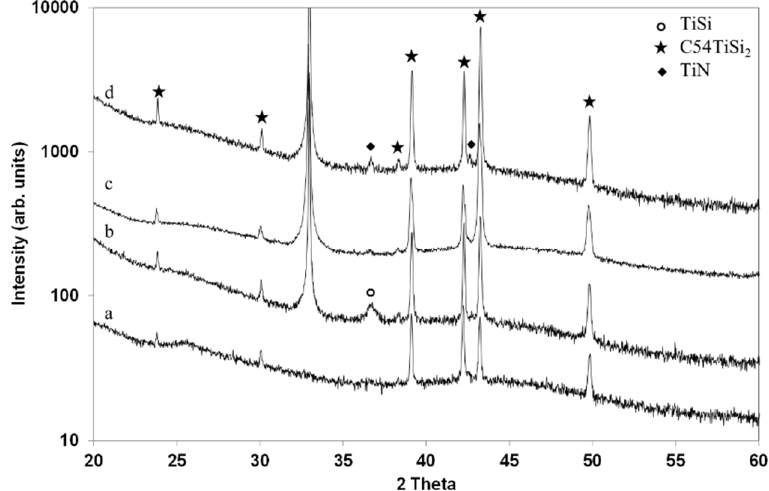
Figure 7. X-ray patterns of Ti films, 250 nm thick, heated at 800 ◦ C and processed in (Ar-33%N 2 -1%H 2 ) for 30 min ( a ), and Ti films, 500 nm thick, heated at 800 ◦ C and processed in (Ar-33%N 2 -1%H 2 ) for 30 min ( b ), 1 h ( c ) and 3 h ( d ).